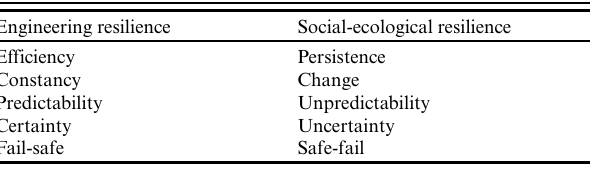
Table 1 . Tensions between engineering resilience and social- ecological interpretations of resilience (adapted after Holling